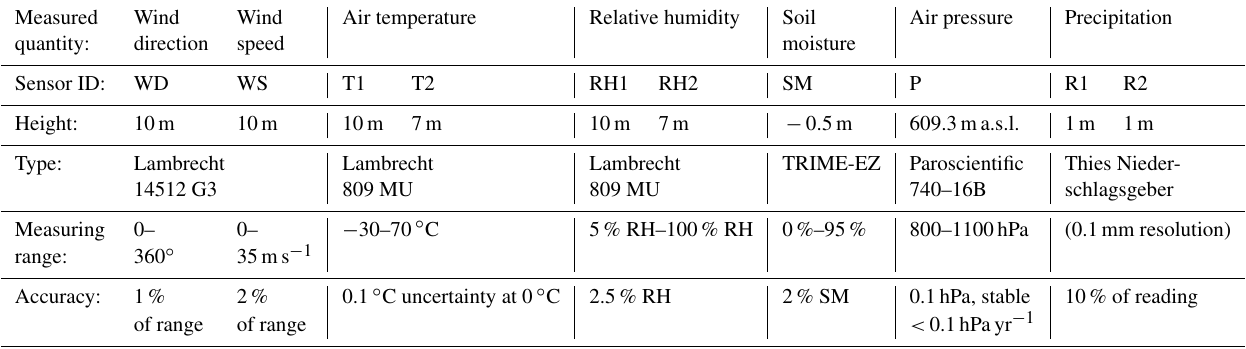
Table 1. Sensors of the local weather station. Except for the pressure sensor, the height is given in meters above the surface. Specified accuracies are manufacturer